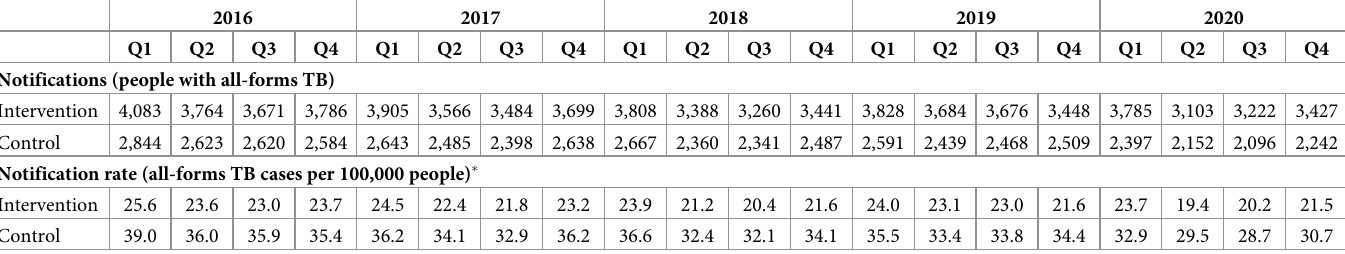
Table 2. Quarterly all-forms TB case notifications and case notification rates from Q1 2016 to Q4 2020, for the intervention area (6 regions) and control area (4 regions).